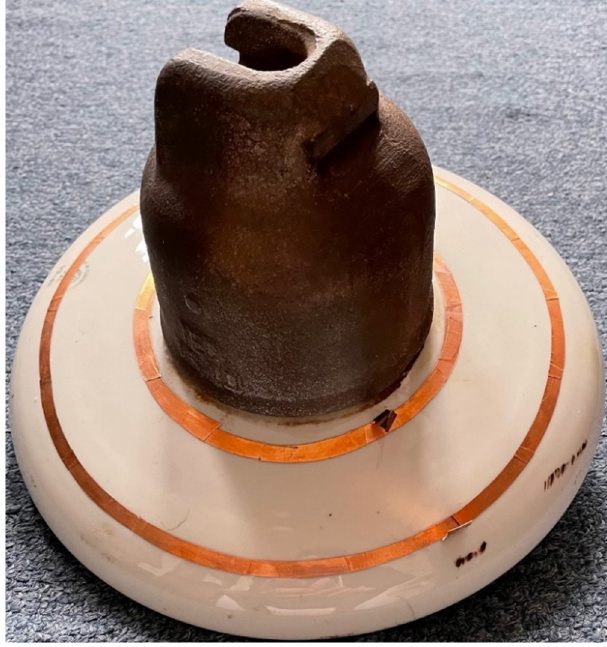
Figure 1. Porcelain insulator with sensing electrodes.